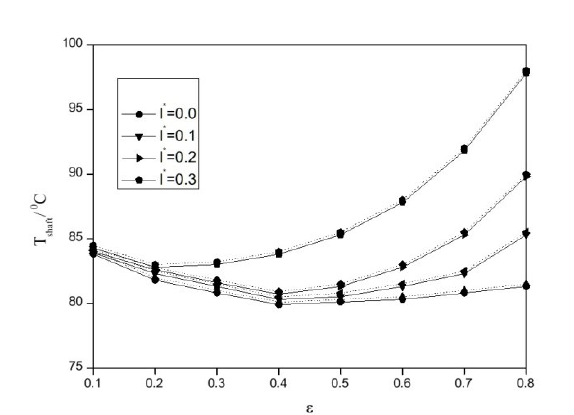
Fig. 5: Load capacity versus eccentricity ratio for different values of the couple stress parameter with roughness parameter 0.1